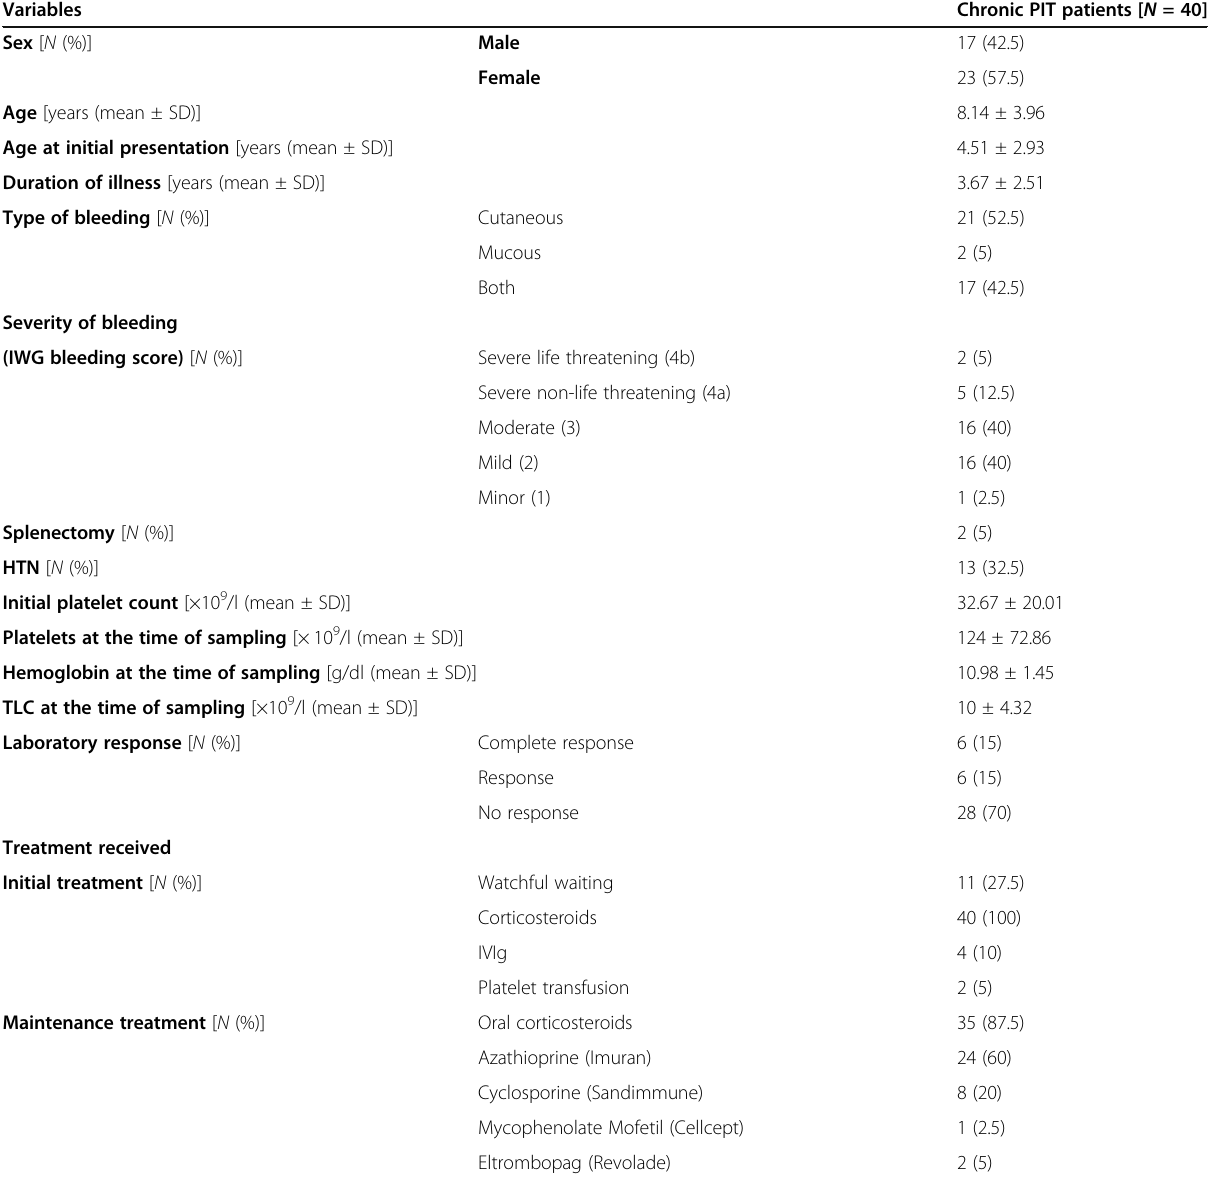
Table 1 Demographic, clinical, and laboratory data of the chronic PIT patients studied.